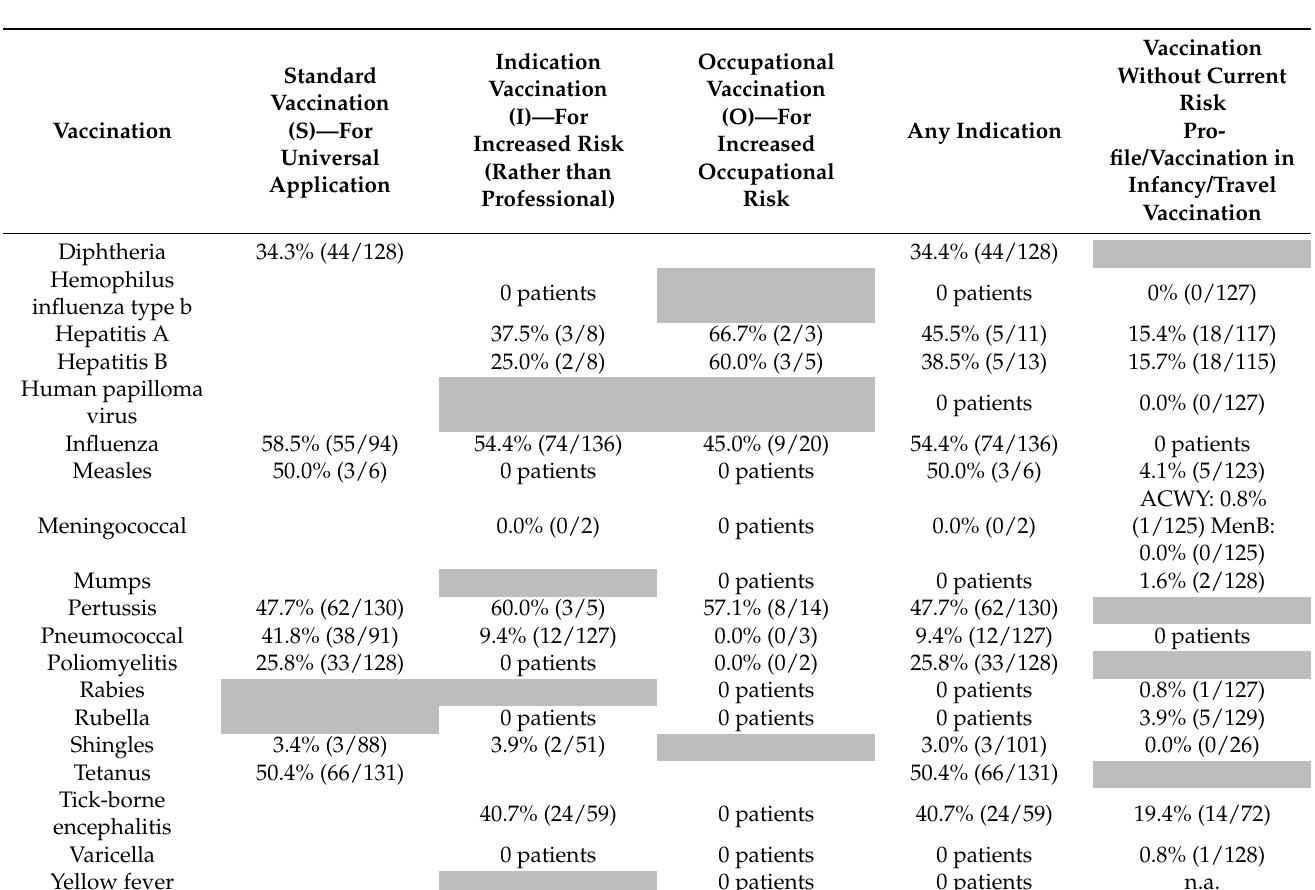
Table A1. Results from the vaccination certificates All vaccinations certificates were available from 110 patients; from 9 patients, at least some information was included, while 17 patients stated that they did not have a vaccination certificate, so these patients were considered as not vaccinated (according to STIKO recommendations). Patients who provided only part of their existing vaccination certificates were considered for the analysis in the case of complete vaccination. Since indications for immunizations vary for different vaccines, every vaccine is listed separately. Shading of cells was used to show that no STIKO recommendation